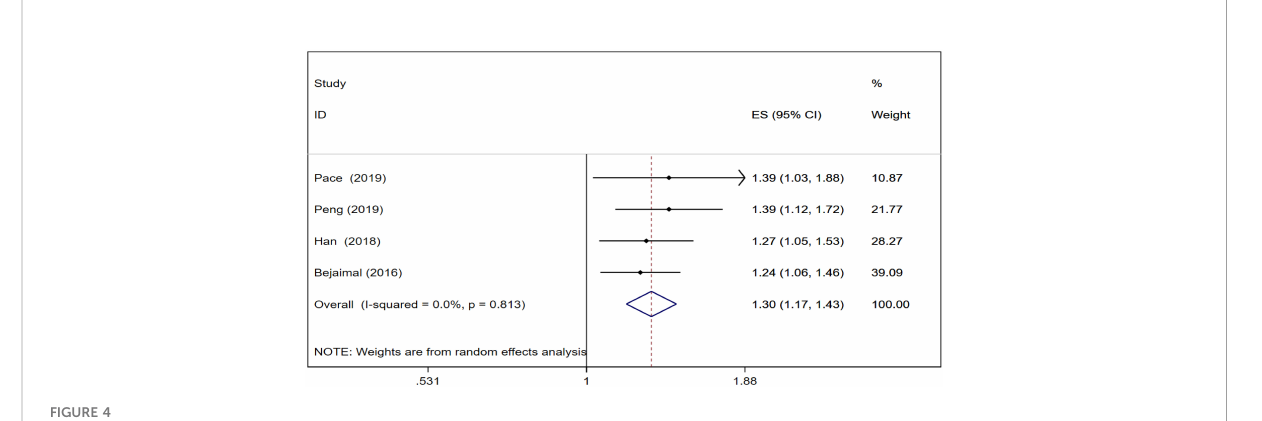
FIGURE 4 Forest plots of thyroid cancer risk in gestational diabetes.